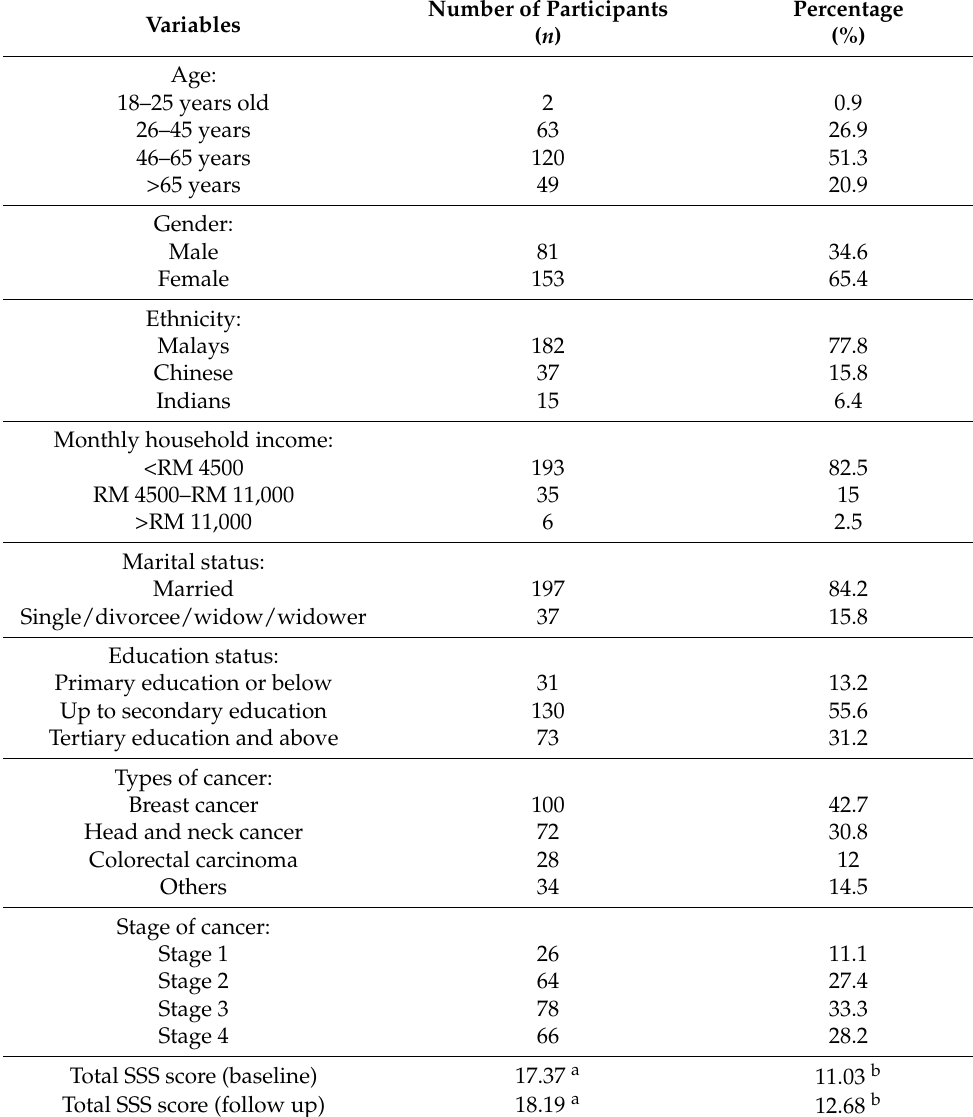
Table 1. Socio–demographic and clinical characteristics of the participants.